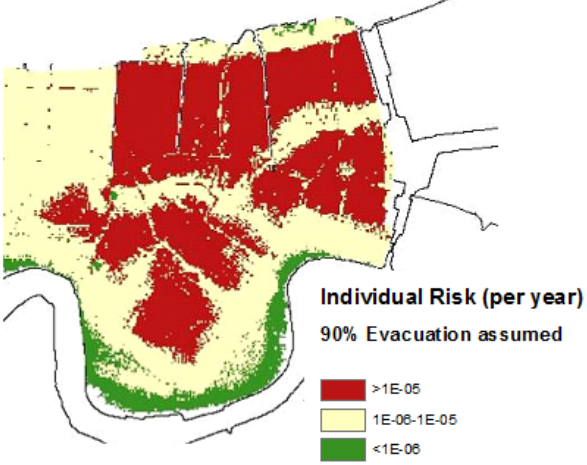
Figure 7. Map of the individual risk for the metro bowl assuming 90% evacuation. Values are given as probability per year.